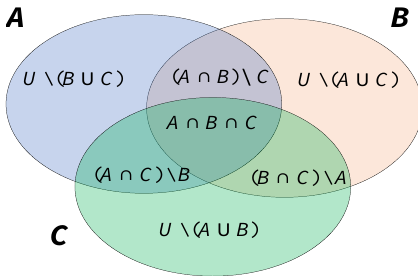
Figure 1. Analysis of failure modes corresponding to a global failure (event U ): an example with three failure modes A , B , and C .